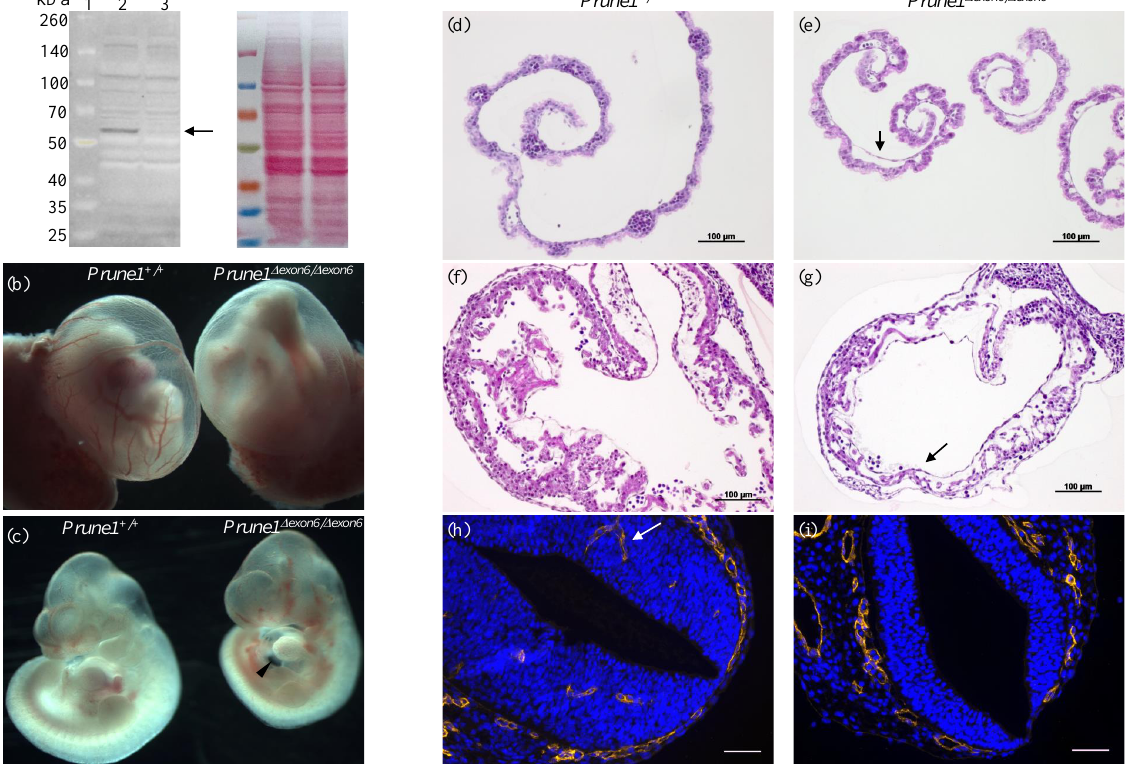
Figure 2. Characterization of the Prune1 ∆ exon6/ ∆ exon6 as a null allele. ( a ) Western blot analysis, demonstrating the complete absence of PRUNE1 protein in mouse embryonic fibroblast (MEF) cells derived from E10.5 Prune1 ∆ exon6/ ∆ exon6 embryo. Lane 1, Protein molecular weight marker; Lane 2, wt MEF; Lane 3, the Prune1 ∆ exon6/ ∆ exon6 MEF. The arrow indicates PRUNE1 protein (~58 kDa) which was only detected in wt MEF cells. Ponceau S staining is shown as a normalization control. ( b , c ) Whole mount imaging of yolk sac and embryos dissected from Prune1 ∆ exon6 intercross at E10.5. The Prune1 ∆ exon6/ ∆ exon6 displayed an avascular yolk sac with primitive vascular plexus and